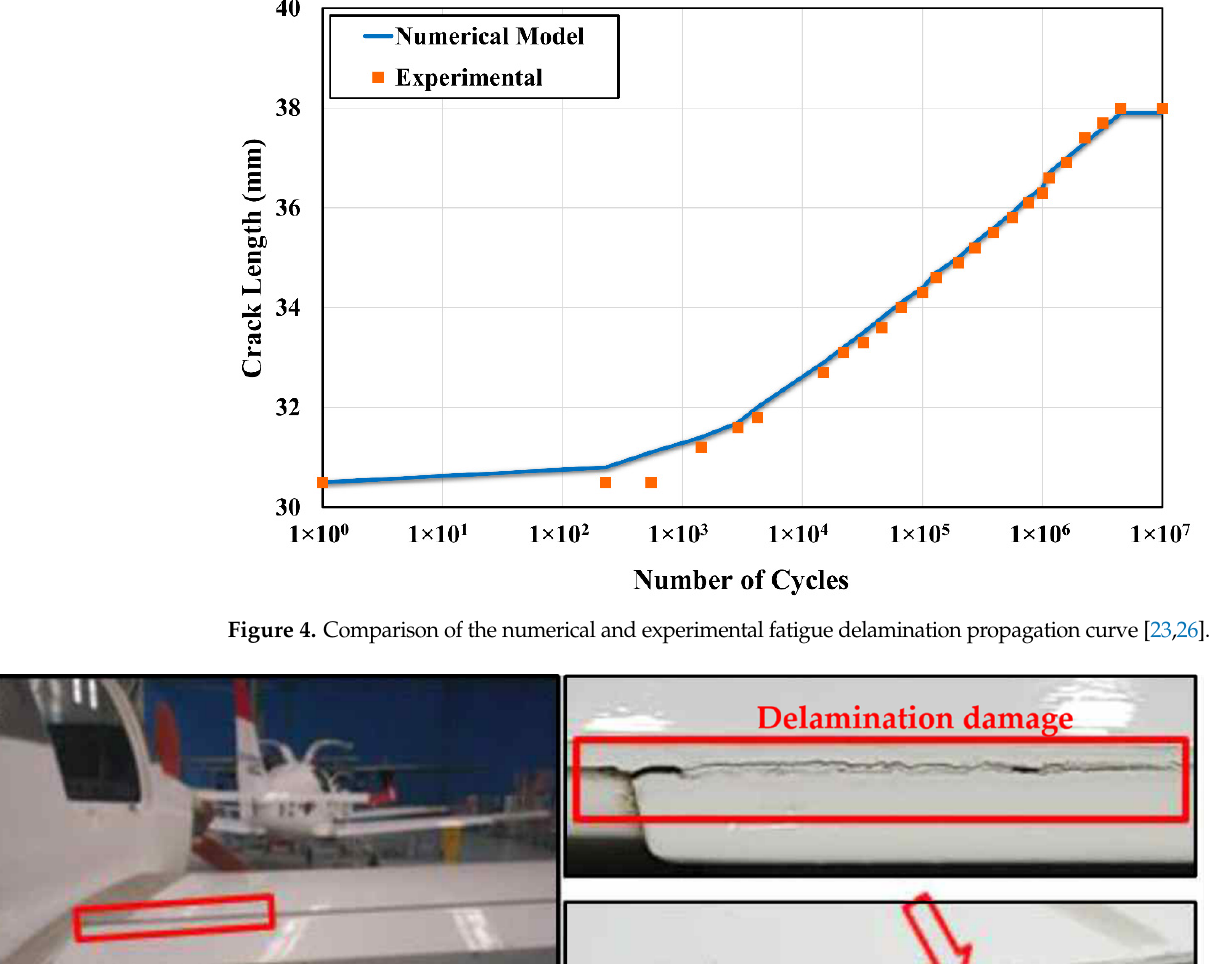
Figure 4. Comparison of the numerical and experimental fatigue delamination propagation curve [23,26].